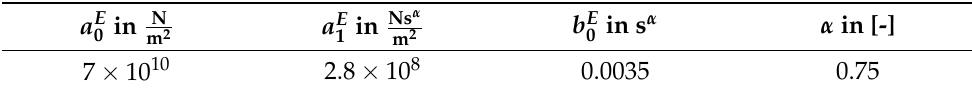
Table 1. List of the fractional derivative parameters—reference values. a E in N 0 m